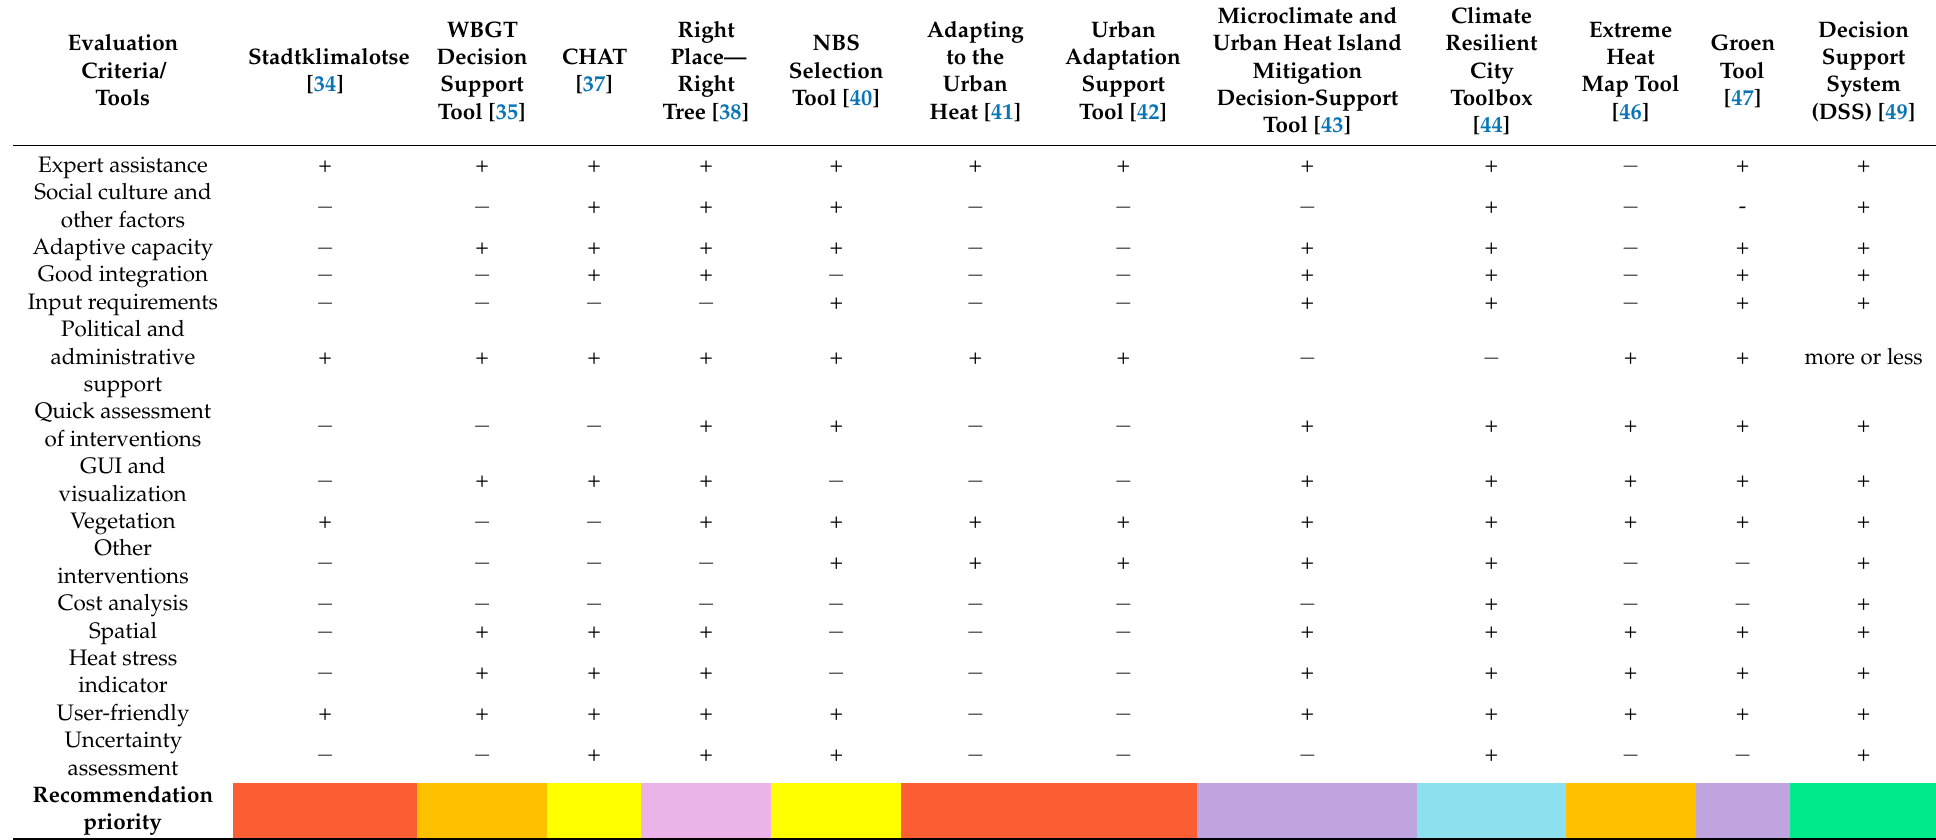
Table 3. DSTs with respect to each